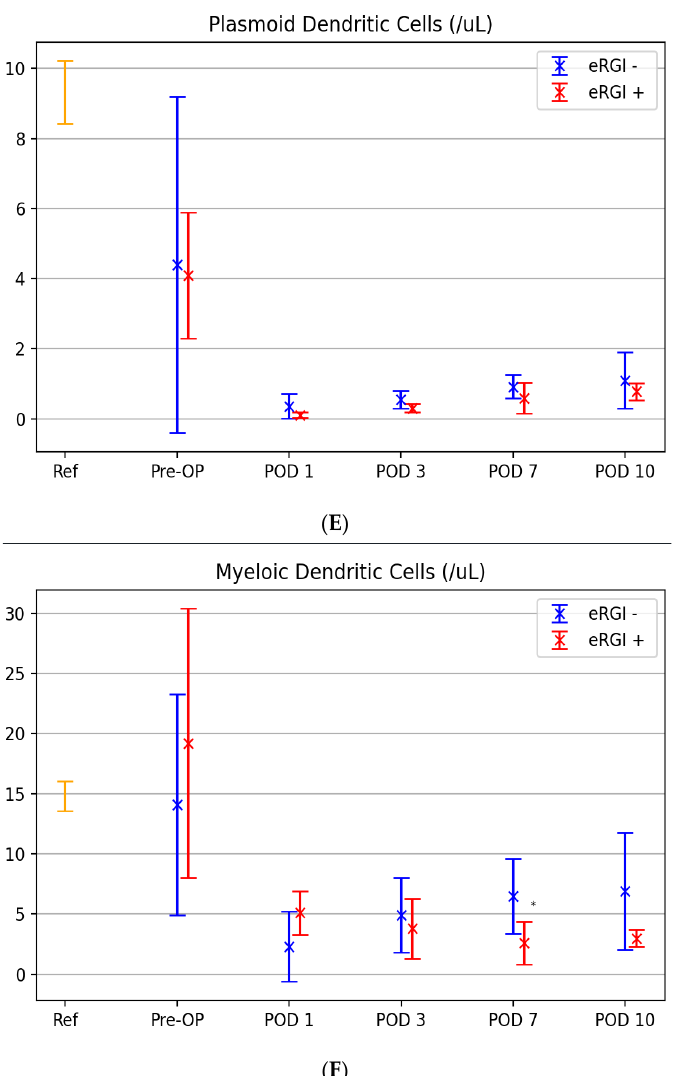
Figure 2. Box plots showing the distribution of neutrophils ( A ), monocytes ( B ), NK cells ( C ), basophils ( D ), mDC ( E ) and pDC ( F ) levels in the eRGI + and eRGI − groups, and standard reference values of innate immune cells established by our laboratory preoperative and on POD 1, 3, 7 and 10 following KT. * p < 0.05, ** p < 0.01; NS, not significant; POD, postoperative days. Postoperative trends of neutrophils and monoctyes were similar in patients with and without eRGI, showing a peak on POD 1 and POD 2, respectively (Figure 2A,B). Neutro- phil levels on POD 1, 3 and 7 and monocyte levels on POD 7 and 10 were significantly higher in patients with eRGI compared to patients without eRGI (all p < 0.05). A significant decrease in NK cell count, basophil levels and DC counts was found between baseline and F). In particular, we found the lowest levels of NK cells and myeloid DC on POD 7 ( p < 0.05), of basophils on POD 3 ( p < 0.05) and plasmacytoid DC on POD 1 ( p <0.05).